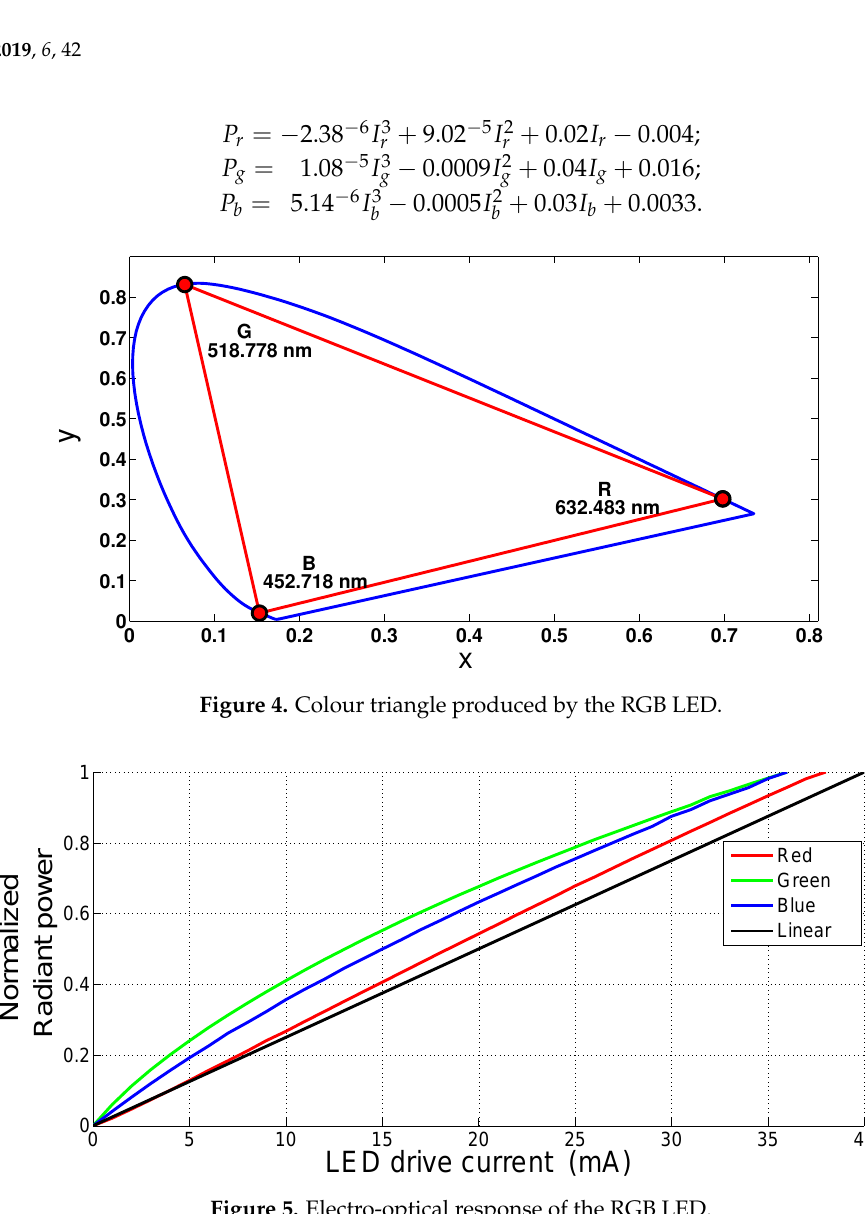
Figure 5. Electro-optical response of the RGB